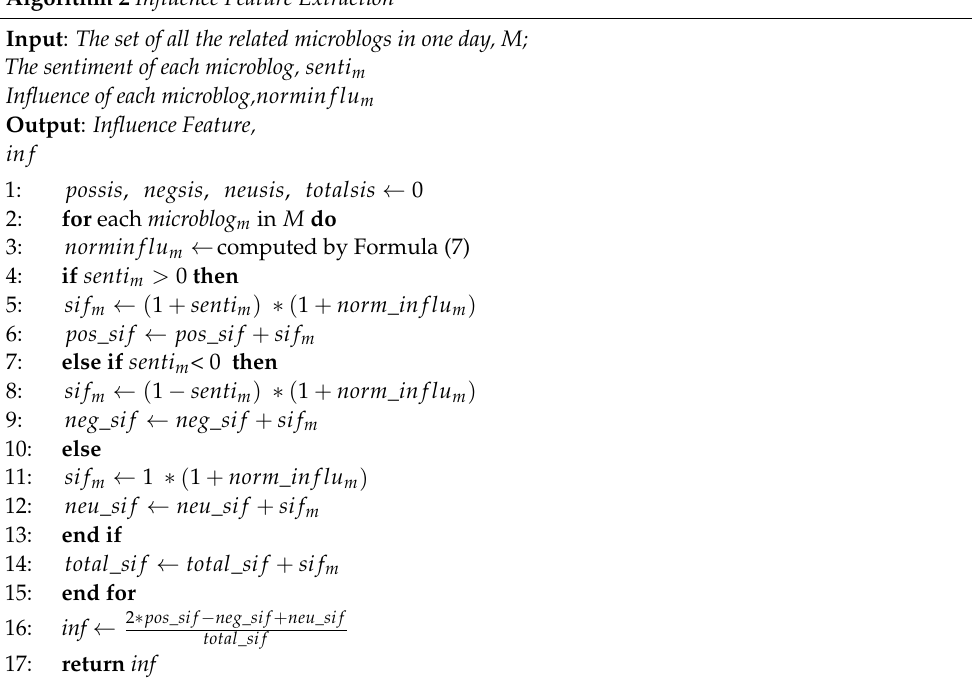
Algorithm 2 Influence Feature